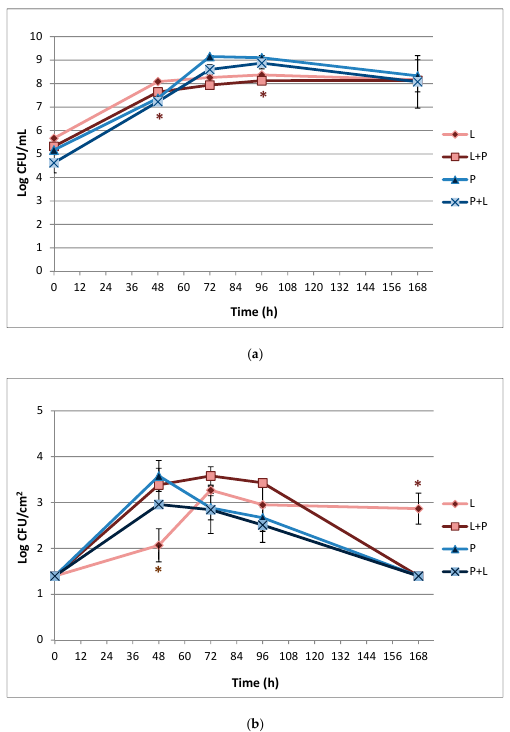
Figure 2. Dynamics of planktonic ( a ) and sessile ( b ) cells of L. monocytogenes LM5 and P. fluorescens pf5 in mono- and dual-species conditions on stainless steel (SS) coupons at 12 ◦ C for 168 h. The results represent average values of three replicates and the bars indicates the standard deviations. The asterisk (*) means statistically significant difference between the mono- and dual-species of each strains for the same incubation time (* p < 0.05). L: L. monocytogenes in single-species; L + P: L. monocytogenes in dual-species; P: P. fluorescens in single-species; P + L: P. fluorescens in